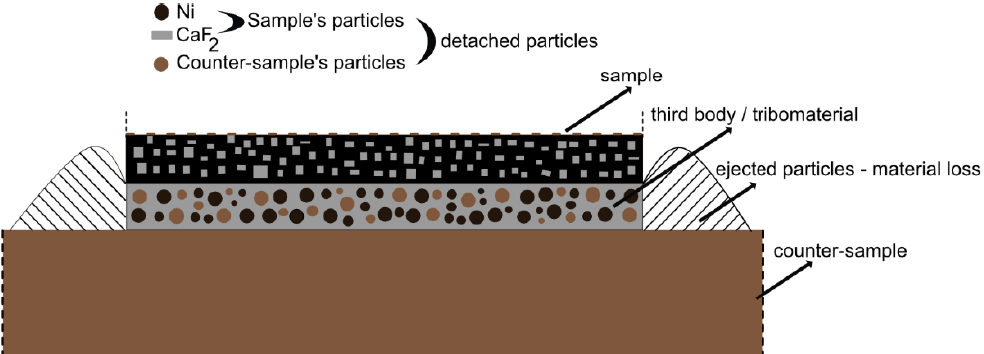
Figure 15. The third body concept in the investigated pure Ni/self-lubricating composites system.